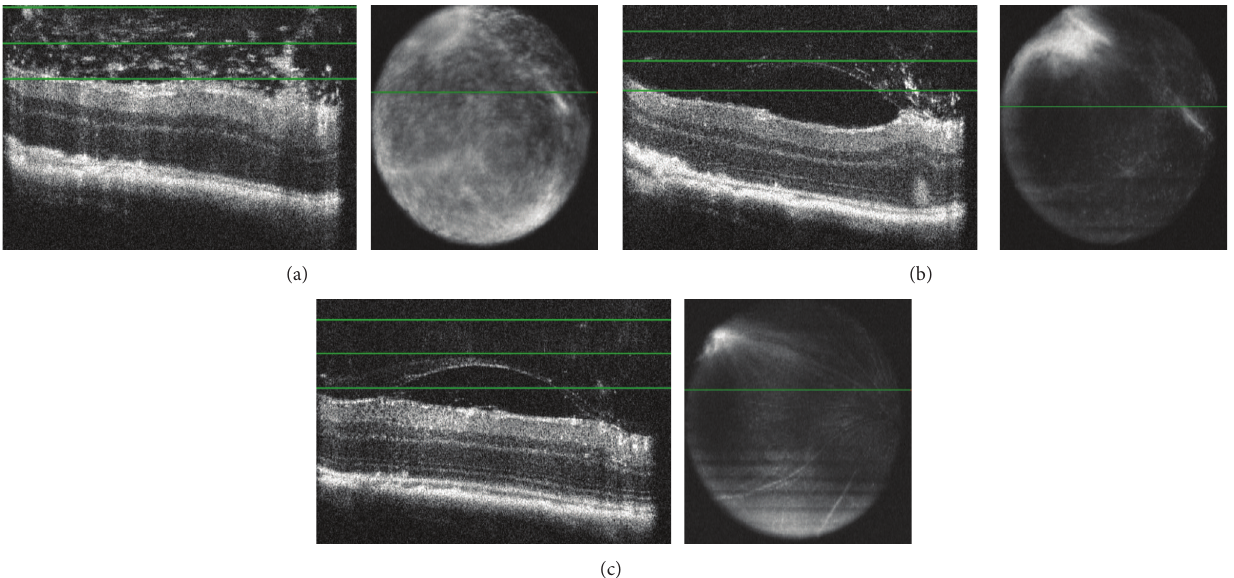
Figure 2: In vivo monitoring of injected cell in damaged retinal tissue. A representative SD-OCT image of an injured retina on the 7th day after Lin − BMC transplantation (a). The green lines on the OCT images (left side) indicate the boundaries of tissue depth displayed in an en face two-dimensional fundus projection (right side). The depth-dependent fundus image at this time point shows injected cells in the vitreous. The cells were uniformly distributed and were homogenous in appearance. The SD-OCT analyses on the 28th day (b) and the 3rd month (c) showed the absence of the injected Lin − BMCs in the vitreous